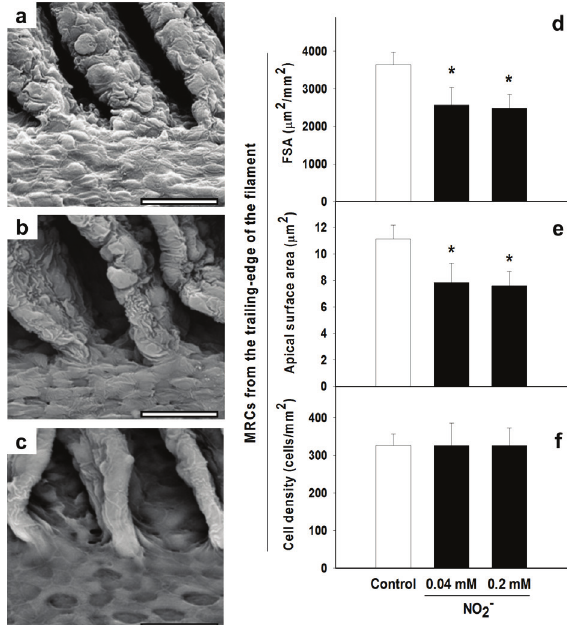
Figure 1 - Light micrographs and morphometry of gills of Figure 2 - SEM and surface measurements of gills of C. C. macropomum . a . Filament and lamellae from the control macropomum . a. Control group. b. 0.04 mM NO 2- . c. 0.2 mM group exhibited numerous MRCs (arrows) and swollen and NO 2- . Note the changes in the structure of lamellae and filament short lamellae. MRCs are easily distinguished in this resin surface after exposure to NO 2- . d. MRC fractional surface area. section because of their round shapes. b. 0.04 mM NO e . Apical surface area. f. MRC density. *Significantly different - : 2 these lamellae were characterized by a gradual decrease in the (p < 0.05) from control. Scale bars = 10  number of MRCs and increased interlamellar space (double arrowhead). Some MRCs exhibit swelling and visible changes in the nuclear material. c. 0.2 mM NO - : scarce MRCs were 2 observed on lamellae. d . Thickness of lamellae; e. Thickness of lamellar epithelium; f. Thickness of filament; g. Thickness of filament epithelium. h. Frequency of MRCs on lamellae and (i) filament. *Significantly different (p < 0.05) from control. Scale bars = 25  m